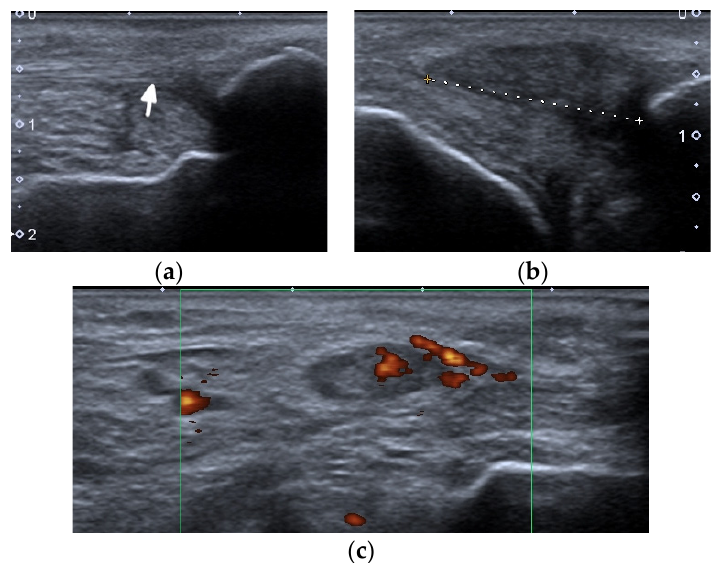
Figure 6. A complete spontaneous tear of the right posterior tibialis tendon (PTT) 2 cm above the medial malleolus in a 46-year-old female with systemic lupus erythematosus. ( a , b ) short-axis gray- scale ultrasound (US) images of the medial aspect of the bilateral ankles show the normal echogenic fibrillar appearance of the healthy left PTT ( a , arrow) compared to an enlarged, torn right hypoechoic PTT in the same region between calipers in ( b ). ( c ) Short-axis power Doppler US image of the affected right side shows hyperemia in the PTT tendon stump, with additional hyperemia in the tendon sheath consistent with tendinopathy and tenosynovitis. Two tiny red dots at the periphery of green Doppler box represent normal vessels.